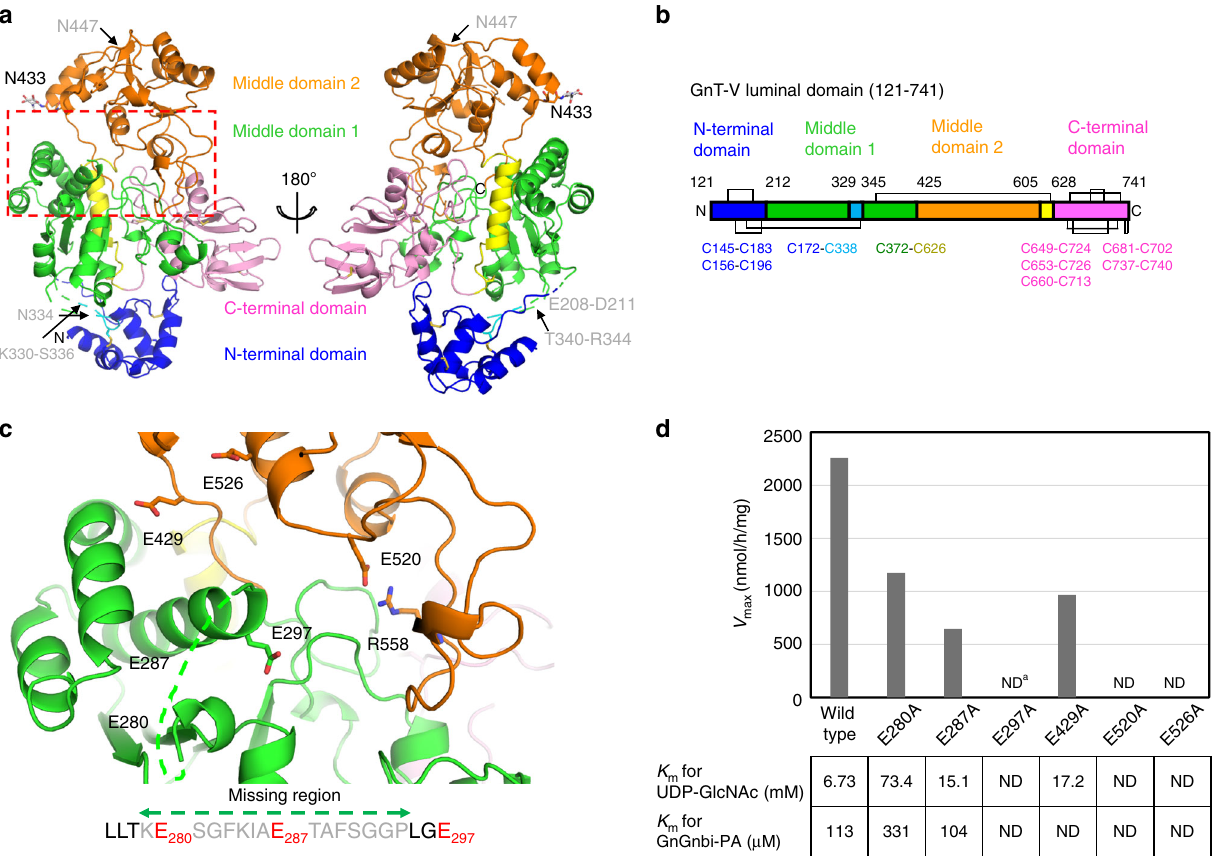
Fig. 2 Overall structure and catalytic residues of GnT-V luminal domain. a Overall structure of GnT-V luminal domain is shown in ribbon model. The N- terminal domain (A128-Y207 in blue and G337-P339 in cyan), middle domain 1 (H212-K329 and I345-L424 in green and E606-H627 in yellow), middle domain 2 (G425-Y605 in orange), and C-terminal domain (G628-L741 in pink) are shown in ribbon models. The disul fi de bonds and N -glycan attached on N433 are indicated with rod models and labeled. Putative catalytic center of GnT-V is indicated with a red dotted box. Among three putative N -glycans (N334, N433, and N447), only GlcNAc residue of N433 is assigned in the fi nal model. Three N -glycosylation sites are indicated. The three missing loops between N-terminal domain and middle domain 1 are also indicated. b Schematic representation of disul fi de bond pattern of GnT-V luminal domain. Cysteine residues, which form disul fi de bonds, are also indicated. c Structural positions of six glutamates (E280, E287, E297, E429, E520, and E526) in GnT-V in respect of mutational experiments are shown in rod model. E280 and E287 are located in the missing loop region (K279-P294) shown as green dotted line. Sequence of missing loop region is shown in lower panel. The side chain of R558, which forms a salt bridge with E526 is also shown in rod model. d Kinetic parameters of wild-type and mutated GnT-V luminal domains. V max values are shown in bar graph representation. K m values for UDP- GlcNAc (donor substrate) and GnGnbi-PA (acceptor substrate) are shown in lower panel. a ND not